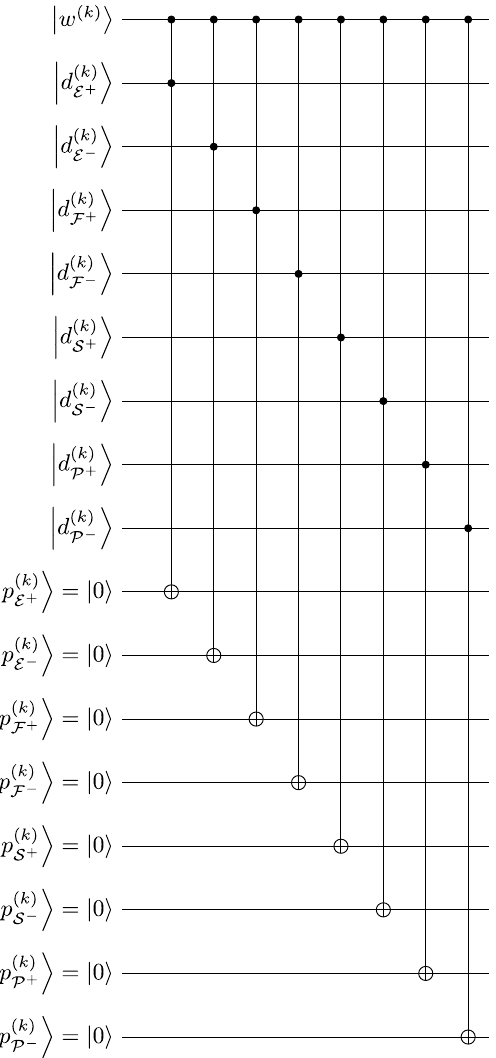
Figure 5. Quantum algorithm for the feature encoding process, corresponding to Eq.